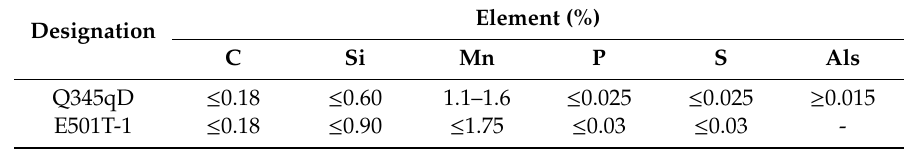
Table 1. The chemical compositions of Q345qD and the welding wire.